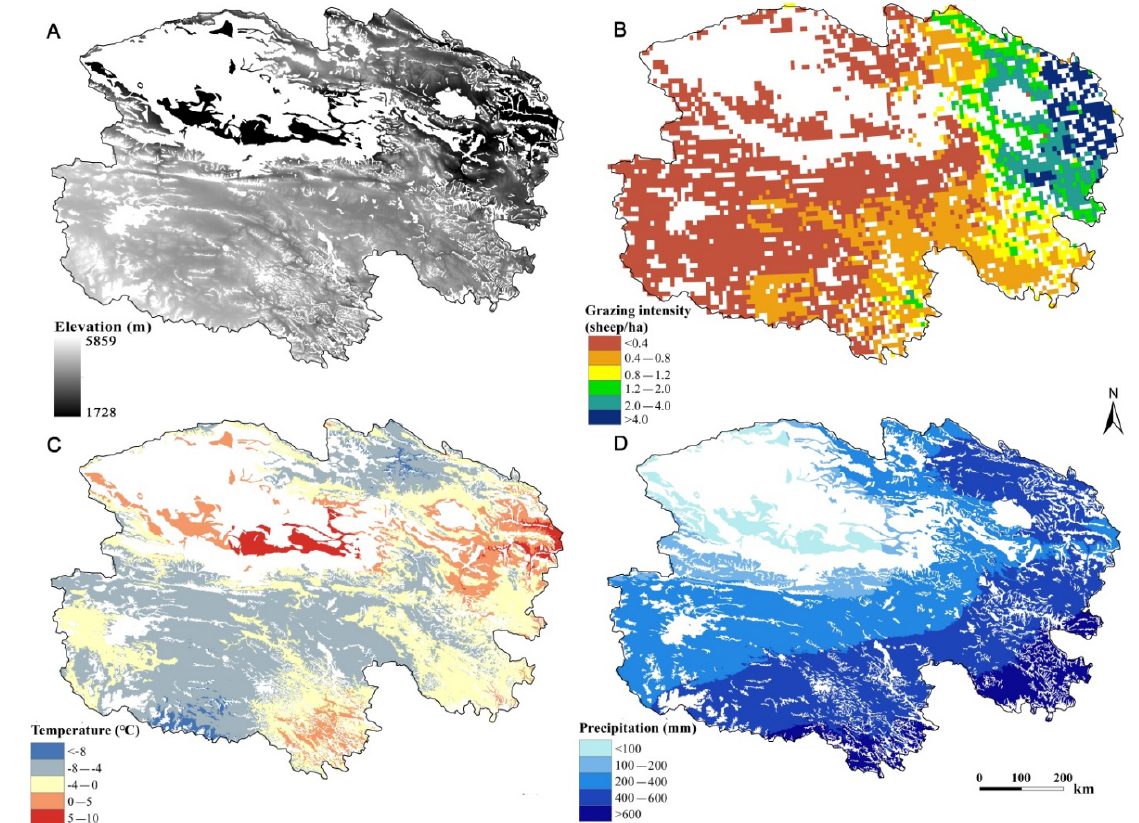
Figure 1. Distribution of elevation ( A ), average annual grazing intensity ( B ), average annual temperature ( C ), and average annual precipitation ( D ) in Qinghai grasslands in the period of 1979 to 2018.